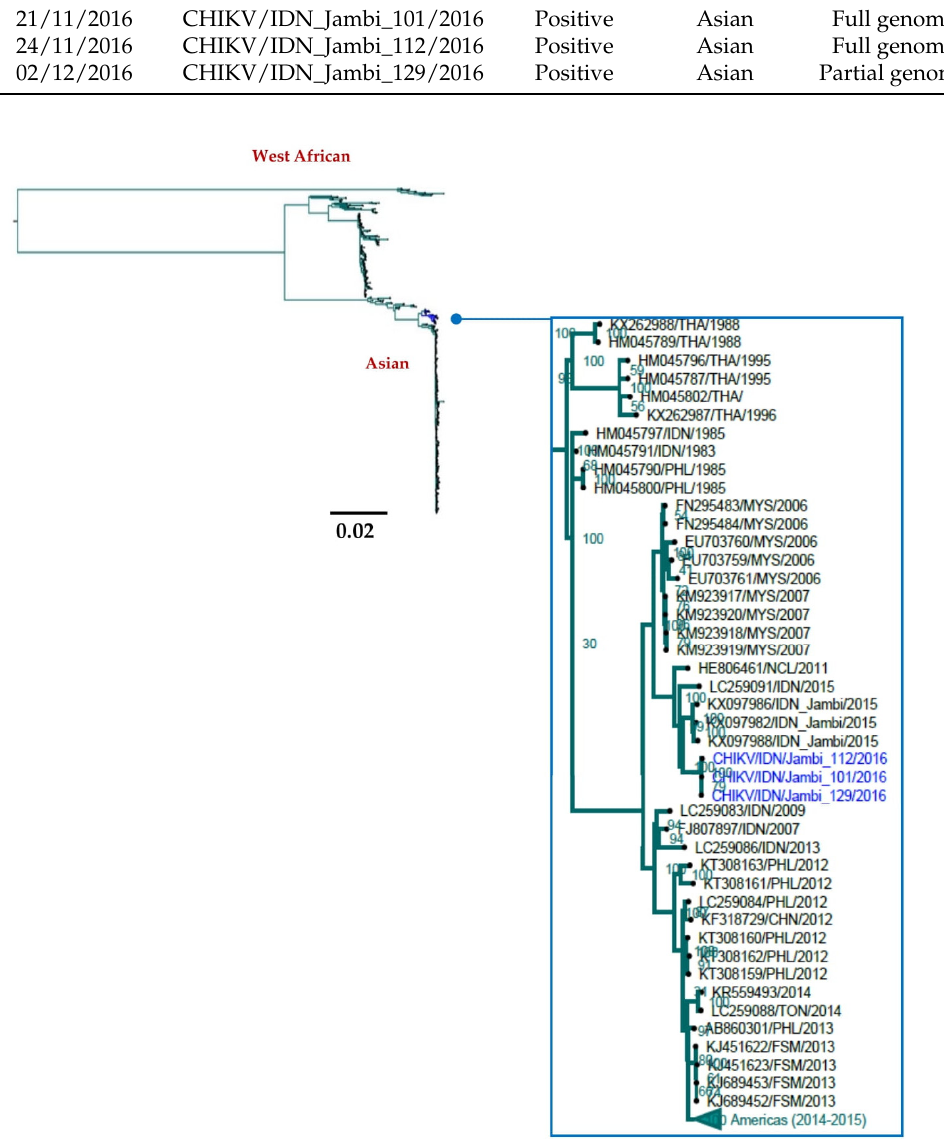
Figure 5. Genome-based phylogeny of CHIKV isolated from Jambi, 2016. The phylogenetic tree was generated using the maximum likelihood method employing RAxML with a GTR+ Γ model of an alignment of three CHIKV isolated in Jambi in 2016, 560 sequences from NCBI. Some phylogenetic clusters have been collapsed (indicated as green) to reveal the positions of the viruses from Jambi. CHIKVs sampled from Jambi are colored in blue. CHN: China, FSM: Federated States of Micronesia, IDN: Indonesia, PHL: the Philippine, MYS: Malaysia, NCL: New Caledonia, TON: Tonga, THA: Thailand.